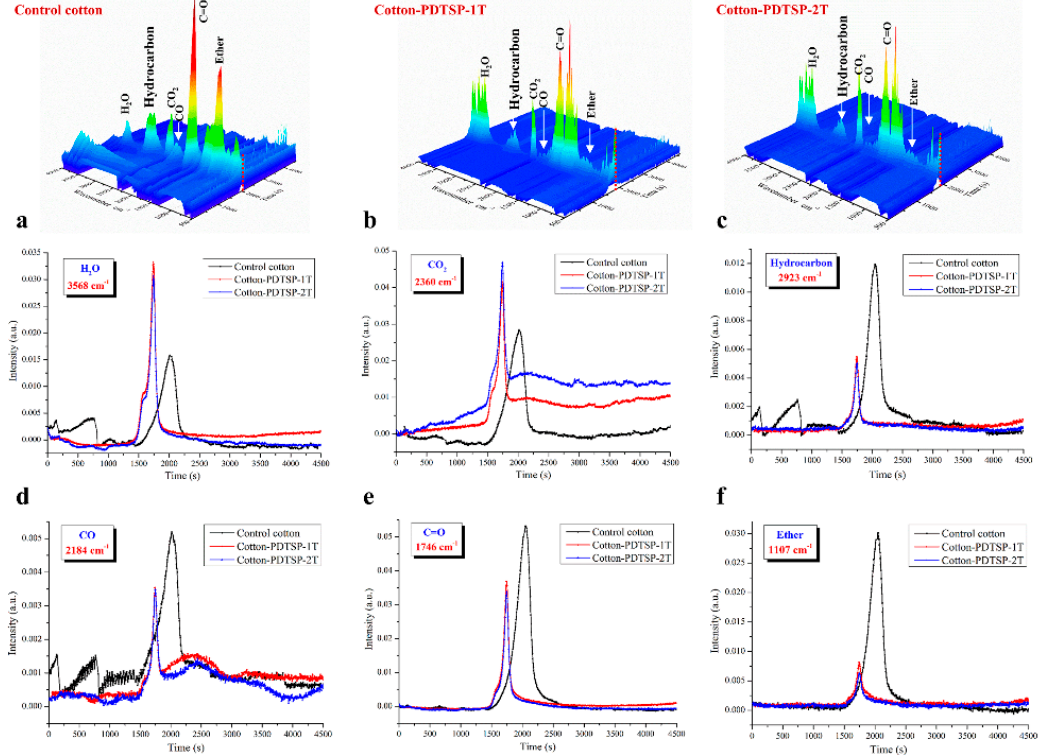
Figure 7. 3D diagrams of gaseous volatiles, and intensity of typical pyrolytic products for Control cotton, Cotton-PDTSP-1T, and Cotton-PDTSP-2T.